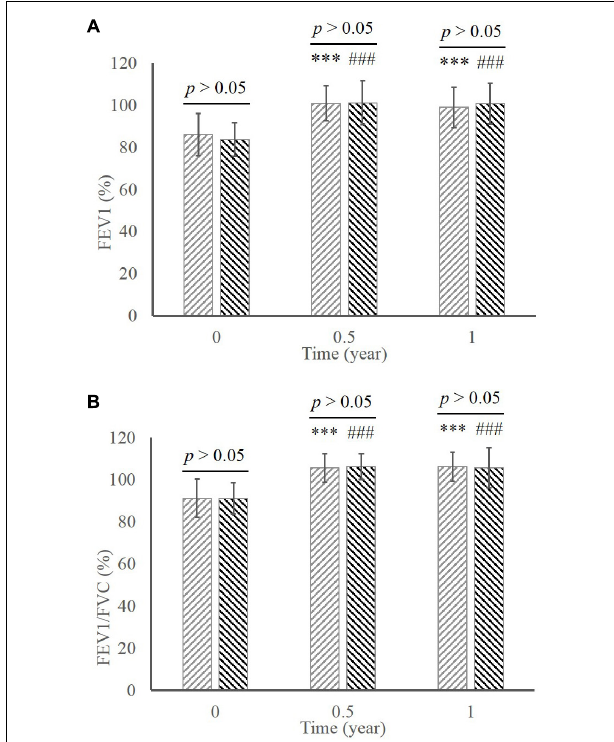
FIGURE 3 | The comparison of pulmonary function between the MD group and the ED group. (A) FEV 1 . (B) FEV 1 /FVC. ∗∗∗ , p < 0.001, significant difference in the MD group compared to baseline; ### , p < 0.001, significant difference in the ED group compared to baseline. MD, morning dosing; ED, evening dosing; FEV 1 , forced expiratory volume in one second; FEV 1 /FVC, FEV 1 /forced volume vital capacity.